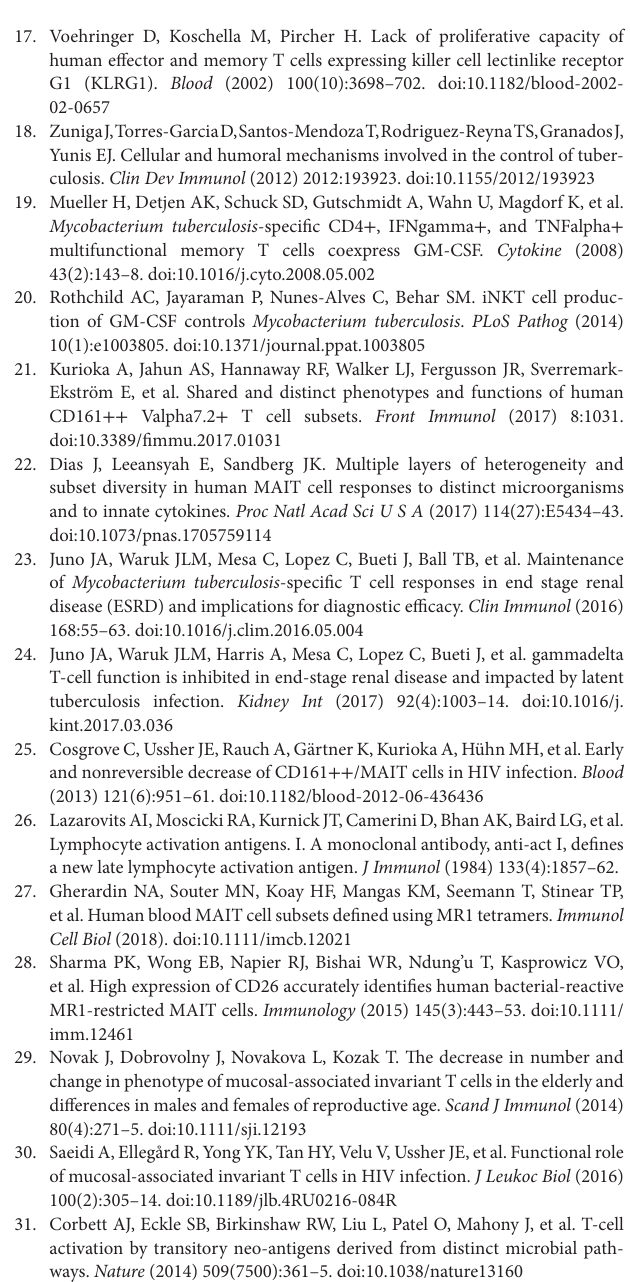
coli and IL-15 ( n = 20 per group). Statistics assessed by Mann–Whitney test. * p < 0.05, ** p < 0.01. FigUre s4 | Analysis of mucosal-associated invariant T (MAIT) phenotype and function based on end-stage renal disease (ESRD) and interferon gamma release assay (IGRA) status. Two-way analysis of separate impact of ESRD status and IGRA status on (a) the frequency of quadruple positive (CCR5 + CCR6 + CXCR3 + CXCR6 + ) MAIT cells, (B) the frequency of tumor necrosis factor α+ MAIT cells in response to Escherichia coli and IL-15 stimulation, and (c) the frequency of granulocyte macrophage-colony stimulating factor, IFN γ or IL-17 + MAIT cells in response to PMA/Ionomycin stimulation. Comparisons performed by two-way ANOVA with Sidak’s multiple comparisons